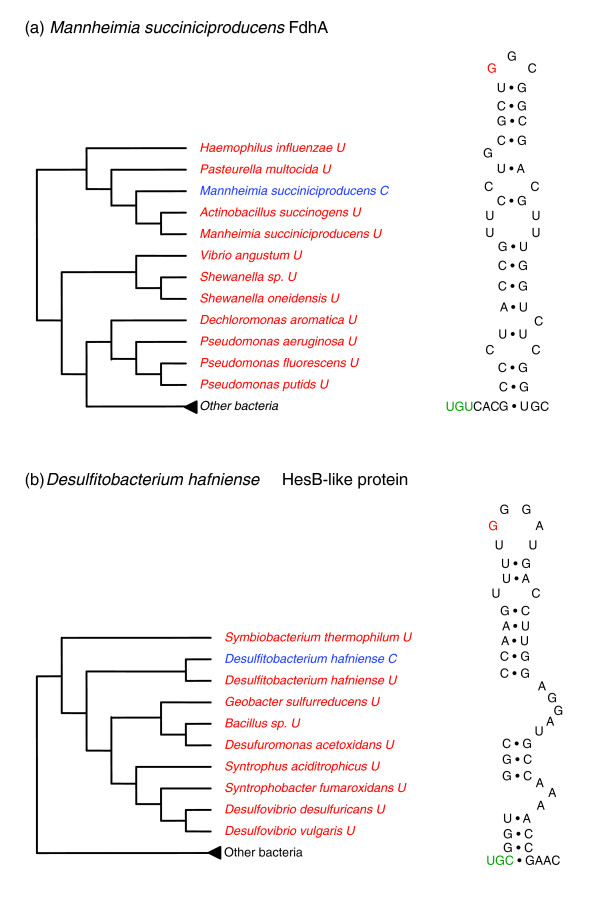
Phylograms and putative remnant bacterial SECIS-like structures in two Cys-containing sequences evolved from Sec-containing homologs. In the phylograms, organisms containing the Sec-containing sequences are shown in red, and organisms containing the Cys-containing homologs are shown in blue. In the bacterial SECIS-like structures, codons for Cys are shown in green and the conserved G in the apical loop is shown in red. (a) Mannheimia succiniciproducens FdhA. (b) Desulfitobacterium hafniense HesB-like protein. C, Cys-containing; SECIS, selenocysteine insertion sequence; U, Sec-containing.